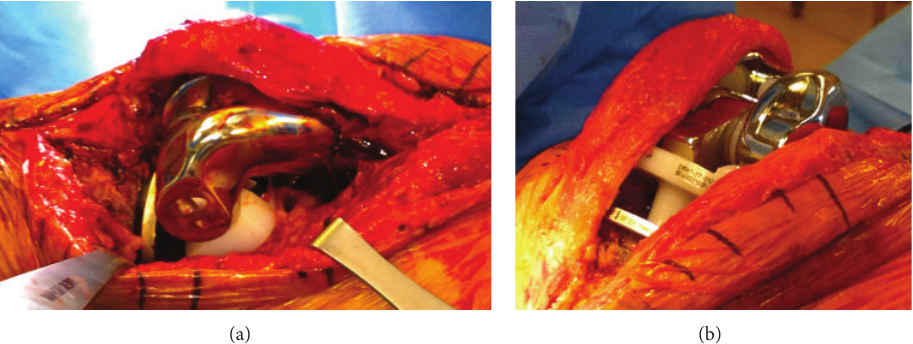
Figure 2: (a) Intraoperative findings illustrating dislocation of rotating hinge stem. (b) Intraoperative opening of the flexion gap causing dislocation.